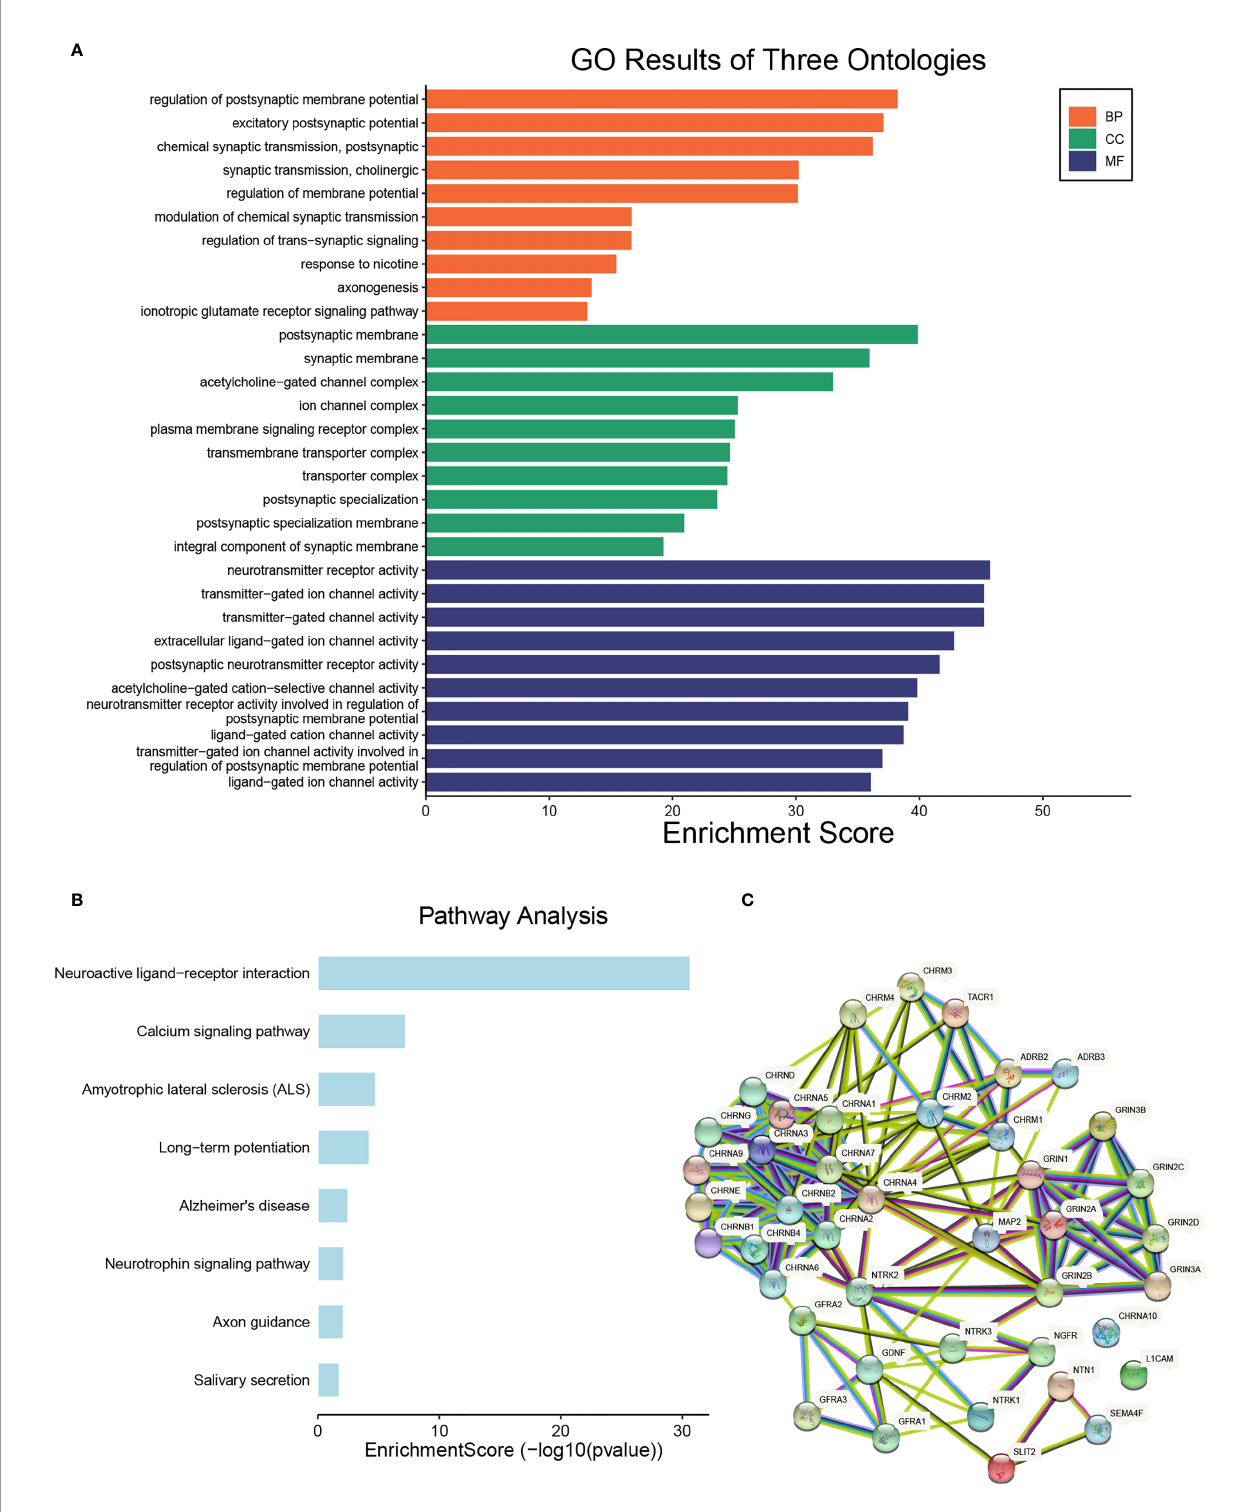
FIGURE 2 | The functional enrichment analysis of NCCGs. (A) The Gene Ontology (GO) analysis. (B) The Kyoto Encyclopedia of Genes and Genomes (KEGG) analysis. (C) The protein-protein interaction (PPI) of NCCGs. NCCGs, nerve-cancer cross-talk genes.